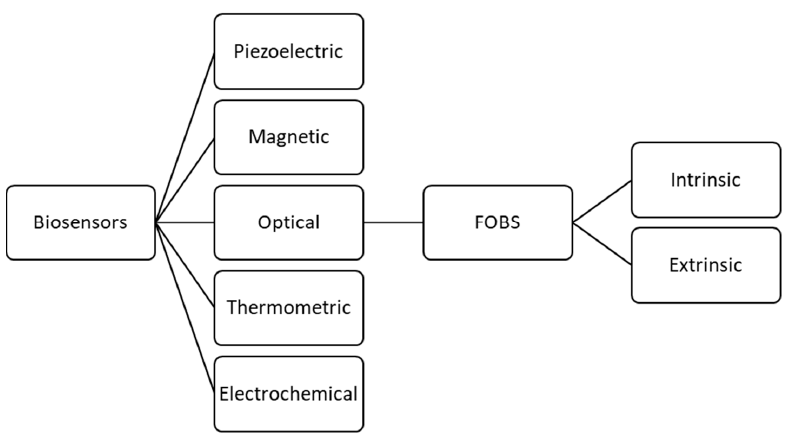
Figure 1. Biosensor breakdown by transducer.